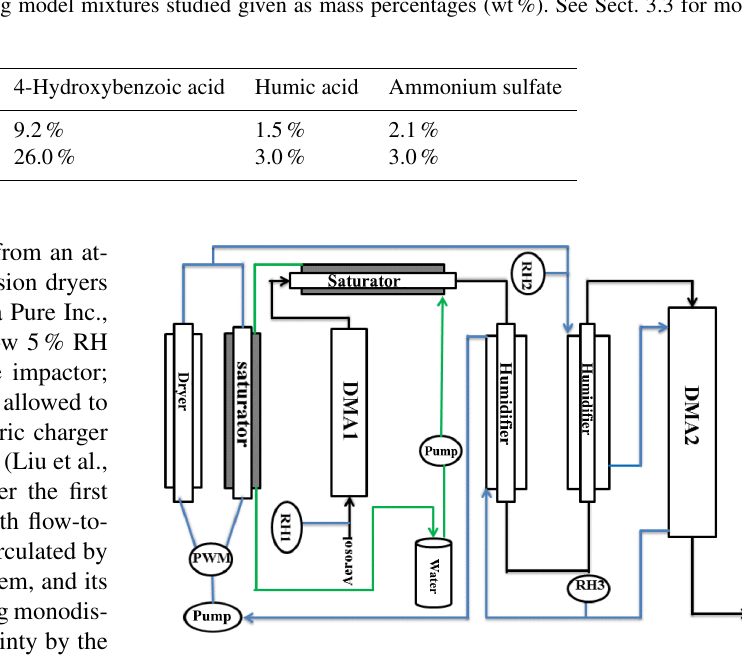
Figure 1. Schematic of the hygroscopicity tandem differential mo- bility analyzer (HTDMA) system. The sheath flow, aerosol flow, and water flow are represented by the blue, black, and green lines, respectively. PWM: pulse width modulator